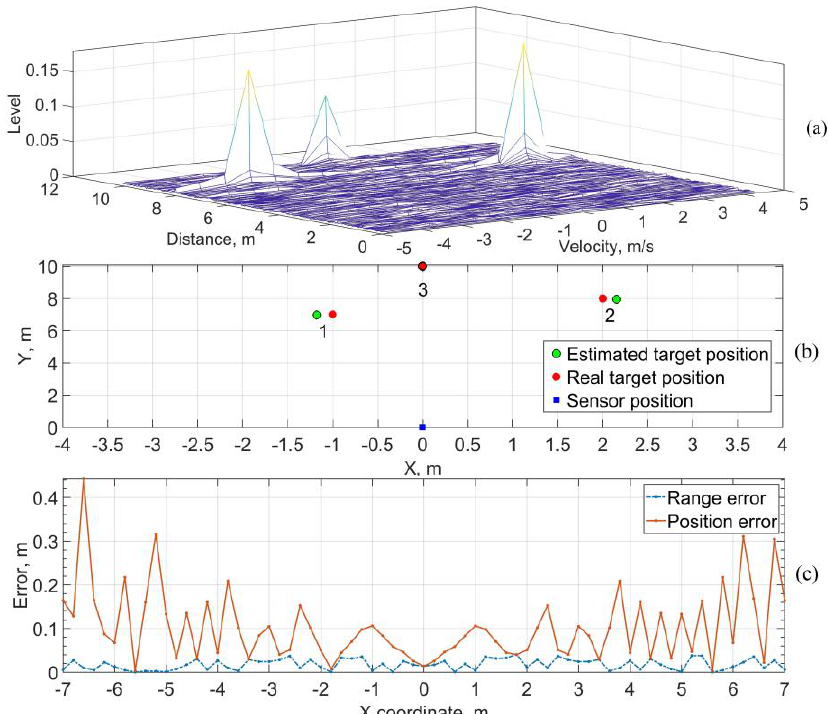
Fig. 5. FMCW first-level model simulation results: range-Doppler plot (a), result of targets location estimation (b) and dependence of target position and range estimation error from X coordinate with fixed Y coordinate